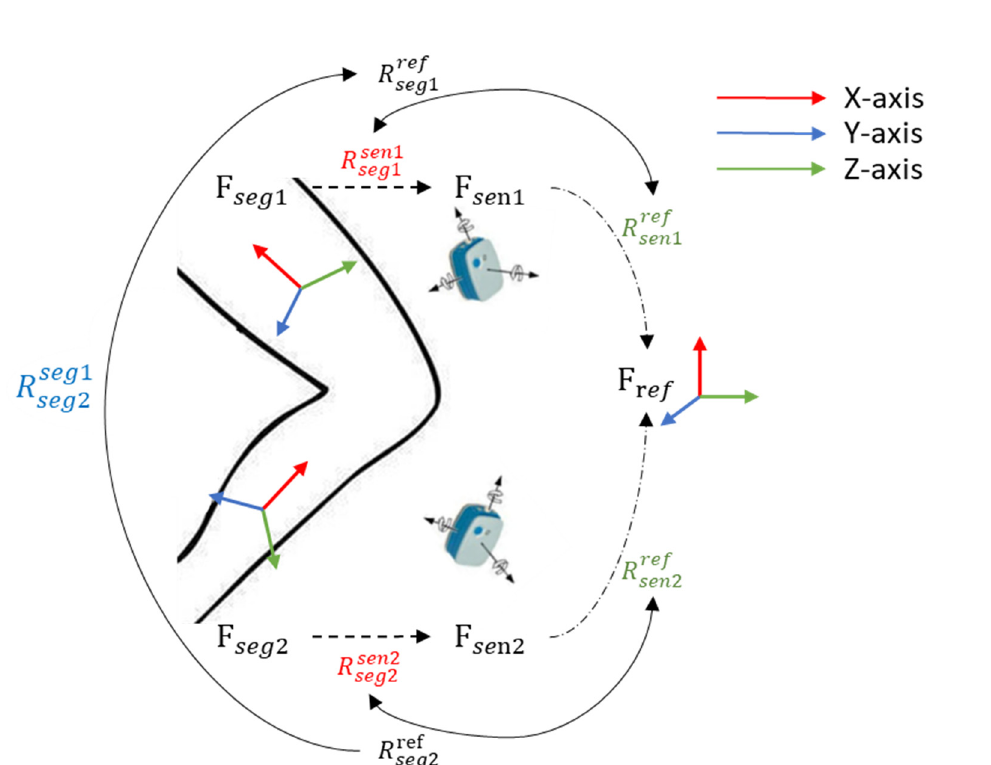
Figure 2. Schematic of joint angle calculation.